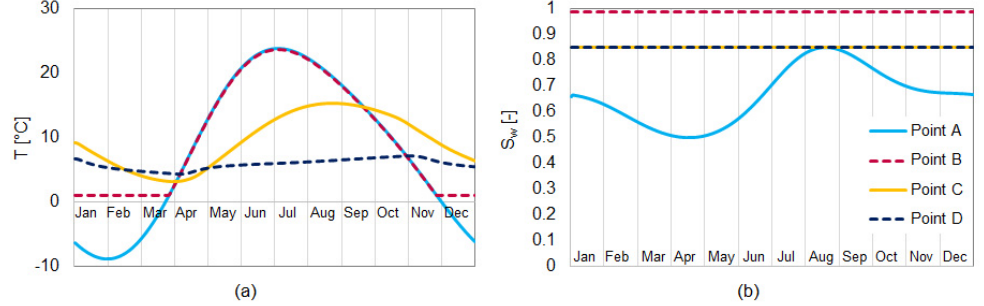
Figure 12. Histories of ( a ) temperature and ( b ) saturation degree for some nodes (A, B, C, and D) in the